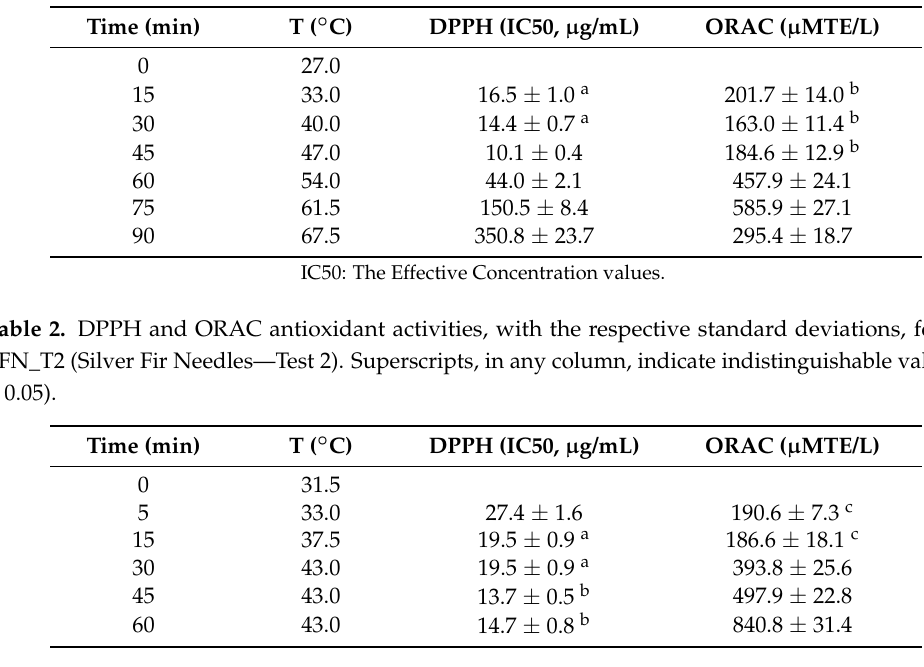
Table 1. 2.20-diphenyl-1-picrylhydrazyl (DPPH) and oxygen radical absorbance capacity (ORAC) antioxidant activities, with the respective standard deviations, for test SFN_T1 (Silver Fir